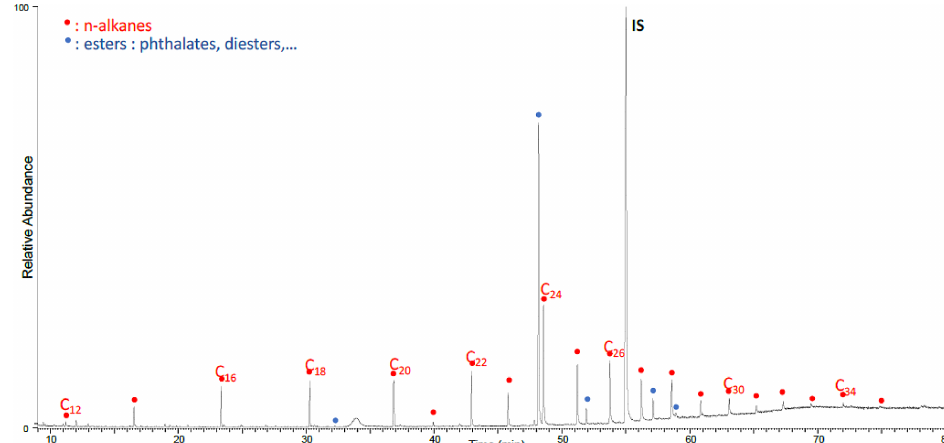
Fig. 6. GC-MS spectra of a PVC industrial sample (PVC 1), indicating the presence of alkanes among the additives (courtesy of Le Milbeau et al.